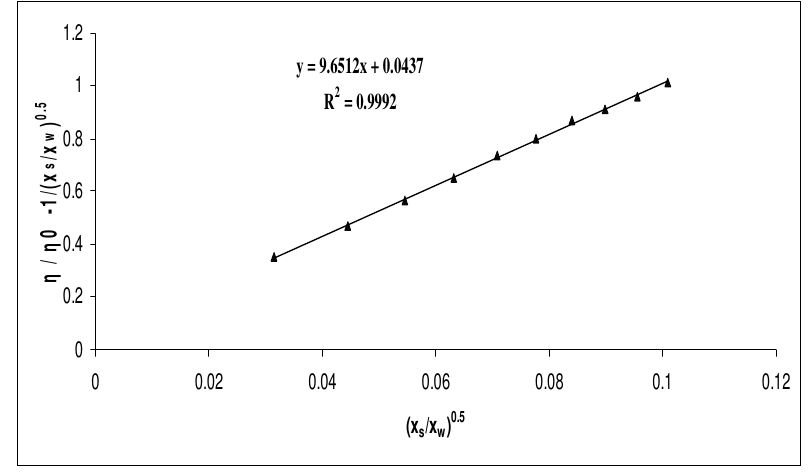
Figure 4. Plot x s /x w0.5 versus (cid:5) / (cid:5) 0 -1/ x s /x